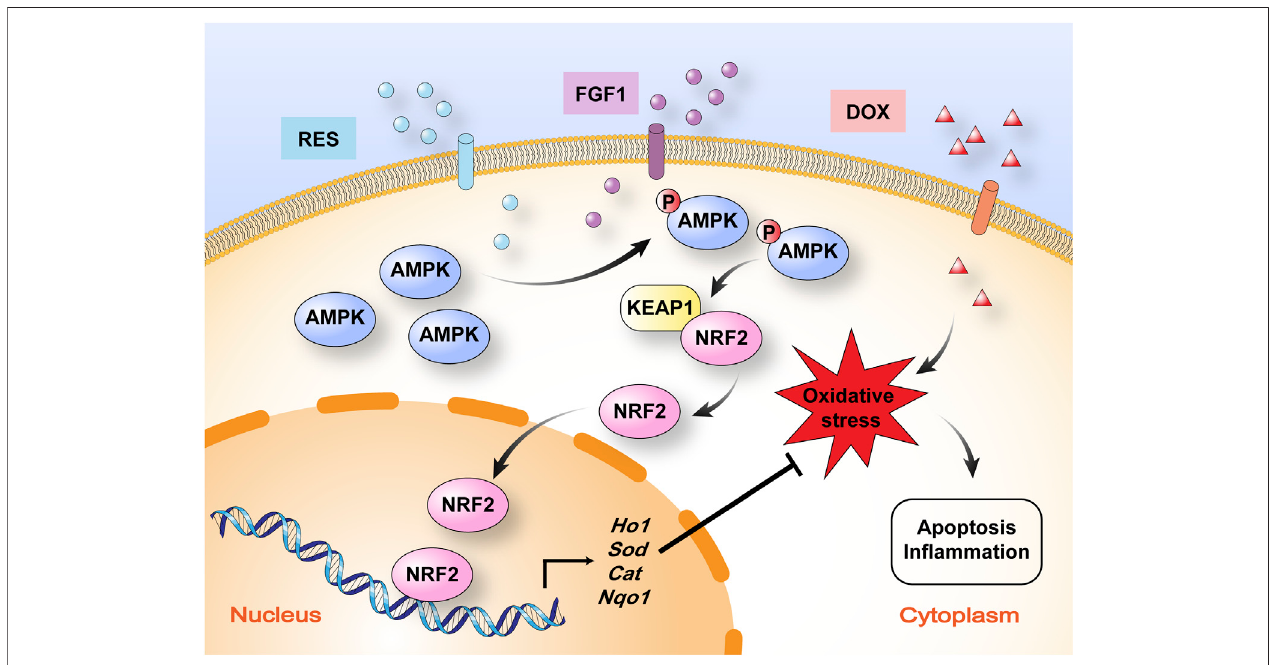
FIGURE 6 | Schematic illustration of the mechanism by which RES in combination with FGF1 protects against DOX-induced hepatotoxicity. RES in combination with FGF1 increases phosphorylation of AMPK expression and nuclear translocation of NRF2 and promotes HO-1 gene expression, which alleviates DOX-induced liver oxidative stress. KEAP1, Kelch-like ECH-associated protein